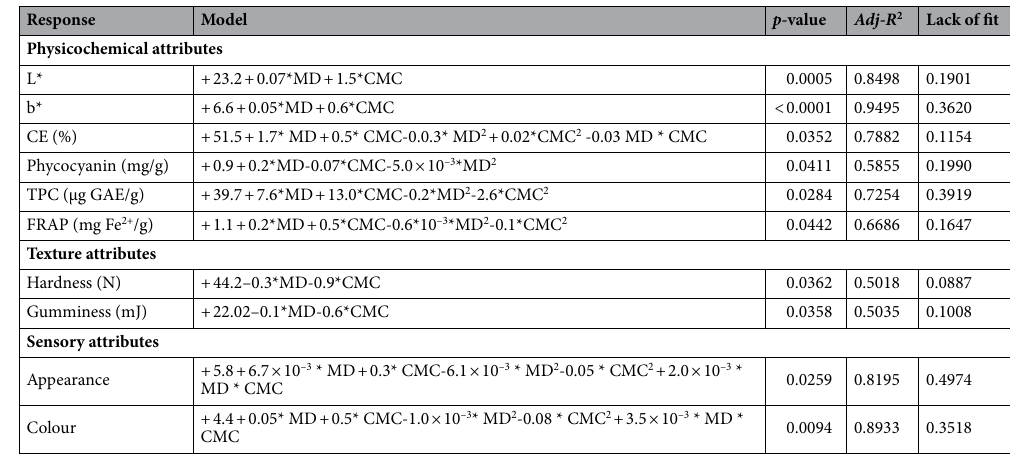
Table 2. Regression coefficients of the models for available